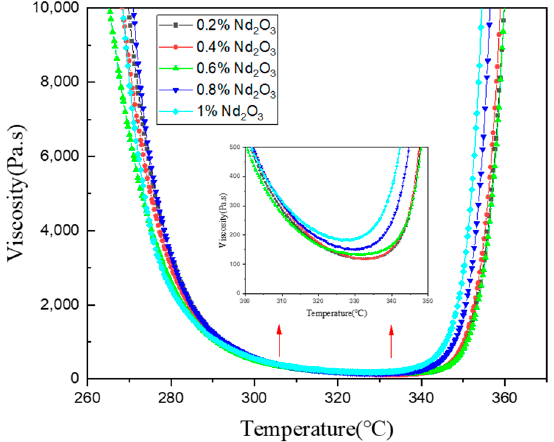
Figure 6. The rheological properties of oligomers with different Nd 2 O 3